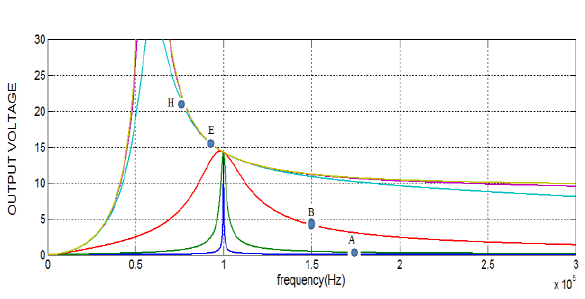
Fig. 9. The V–I curve of the LLC resonant converter